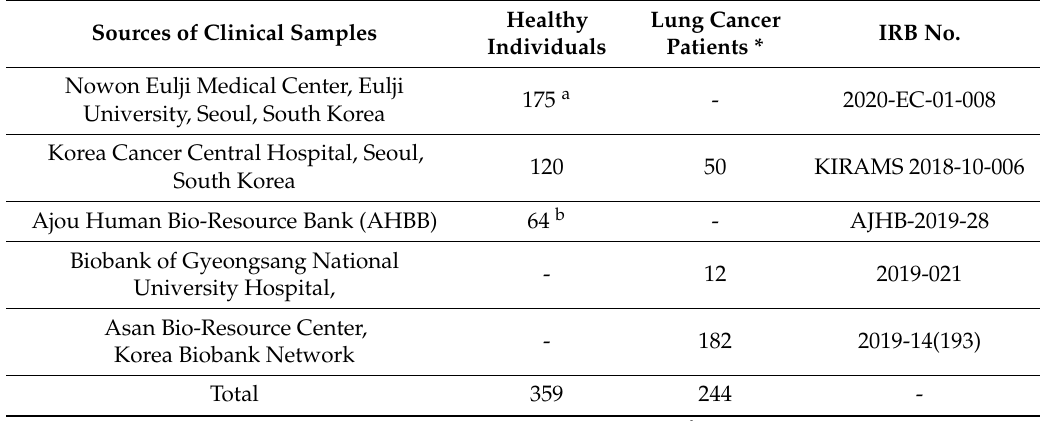
Table 1. Clinical samples ( n = 603) obtained from healthy individuals ( n = 359) and cancer patients ( n = 244). Sources of Clinical Samples